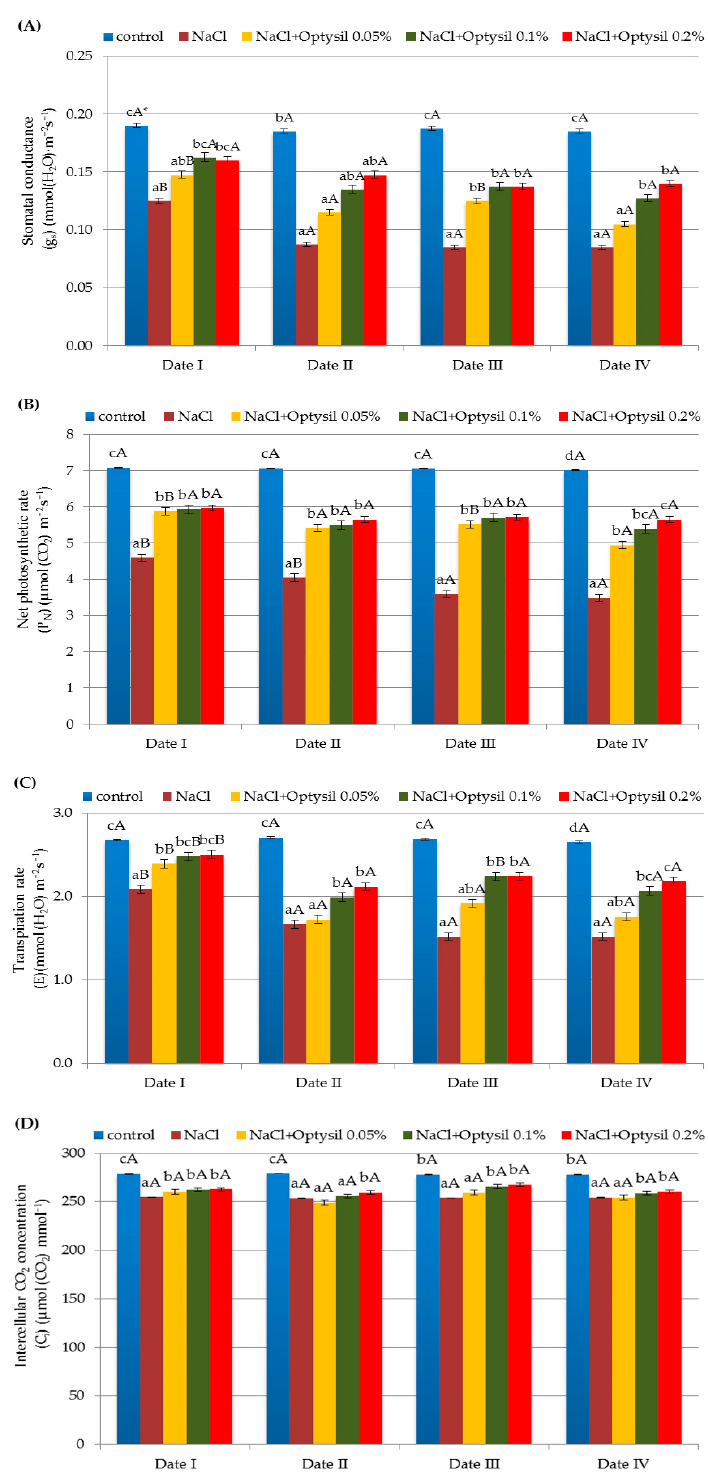
Figure 4. The effect of factors of experiment and measurement date on gas exchange parameters: stomatal conductance (g s ) ( A ), net photosynthetic rate (P N ) ( B ), transpiration rate (E) ( C ) and in- tercellular CO 2 concentration (C i ) ( D ) in oat plants (Date I and Date II, 2 and 7 days after first Si application; Date III and Date IV, 2 and 7 days after second Si application); statistical data are ex- pressed as mean ± SD values. * Capital letters show significant differences between the means in the measurement dates, and lowercase letters show significant differences between the means at next measurement dates ( p =